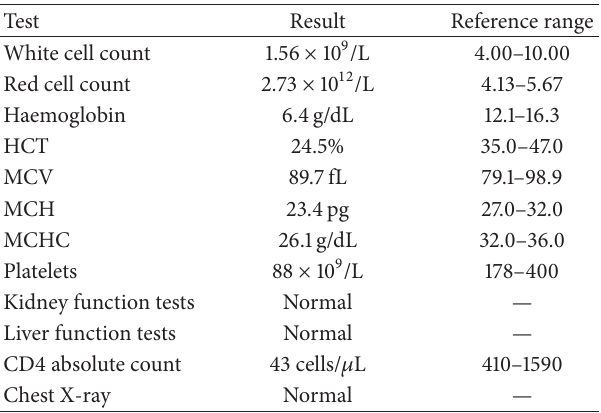
Table 1: Initial investigations done at